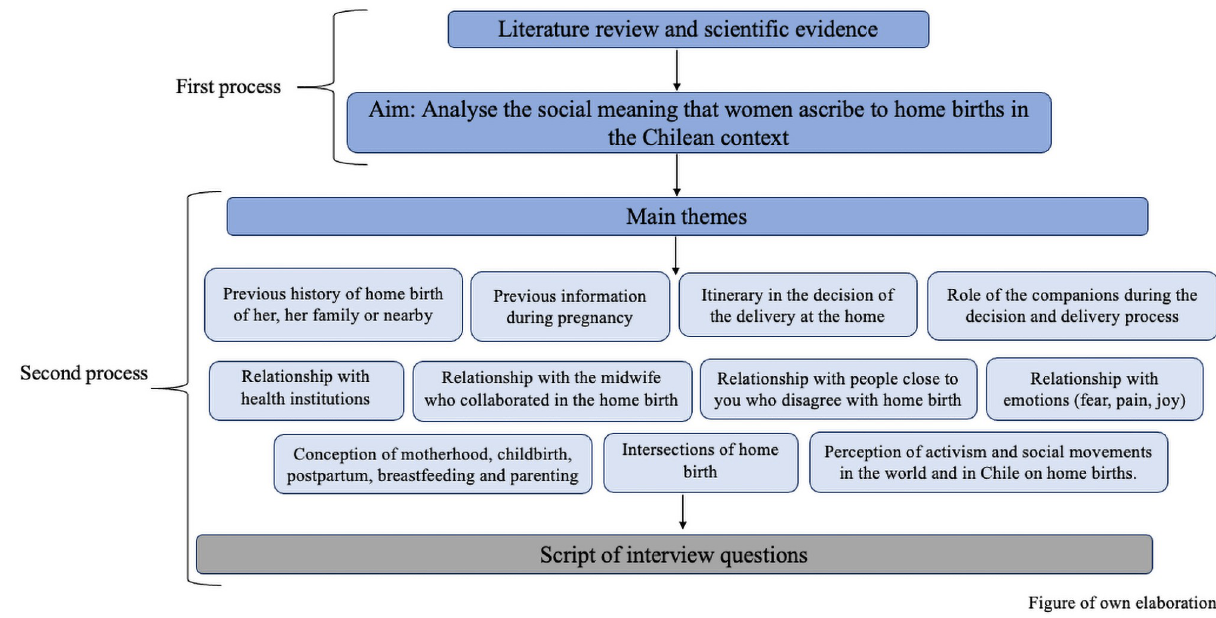
Fig 2. Script drafting